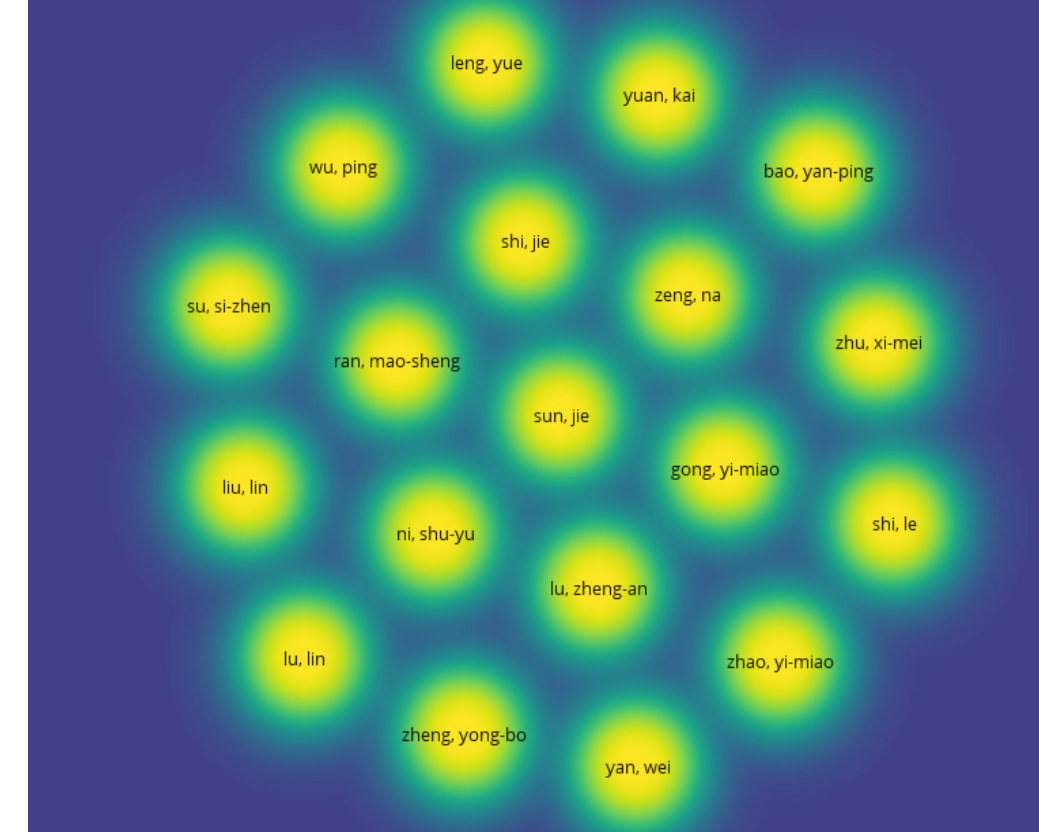
Figure 3. Mapping analysis of the authors from the 37 selected studies.